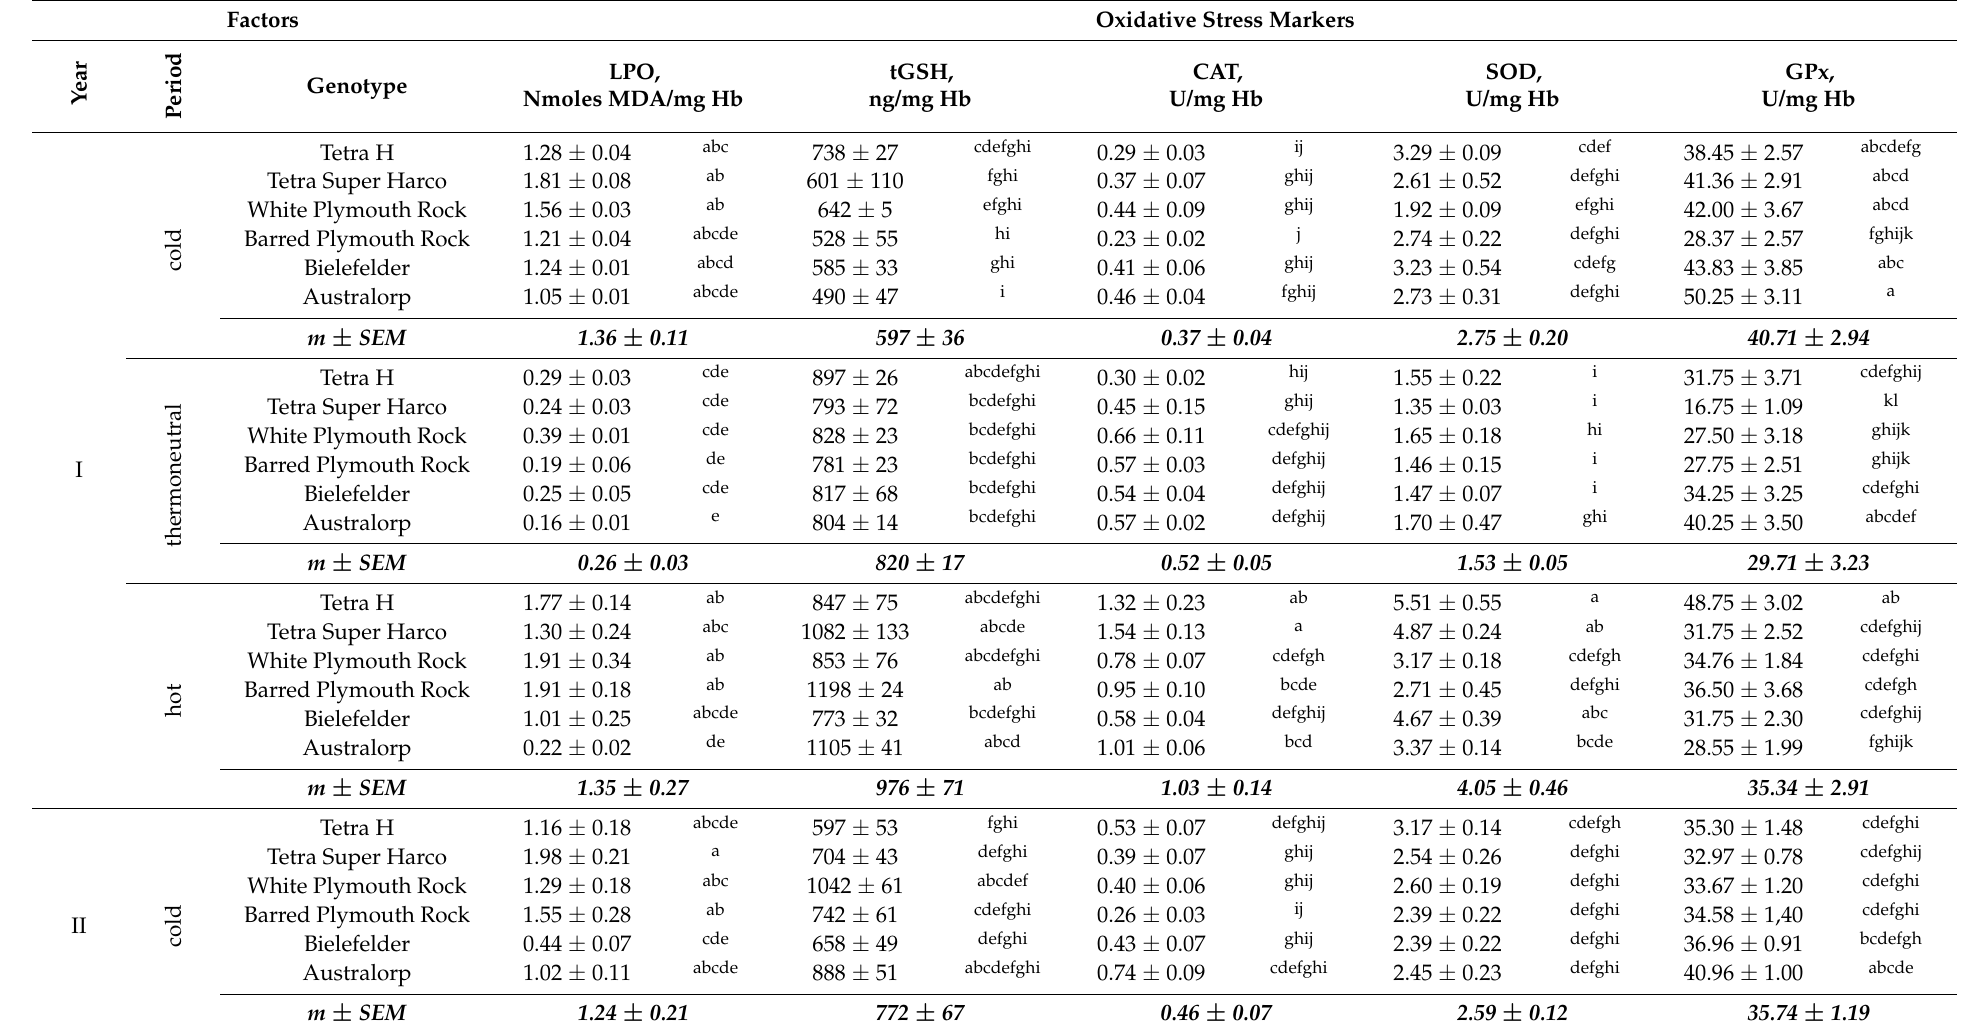
Table 3. Oxidative stress markers in different chicken genotypes, years, and